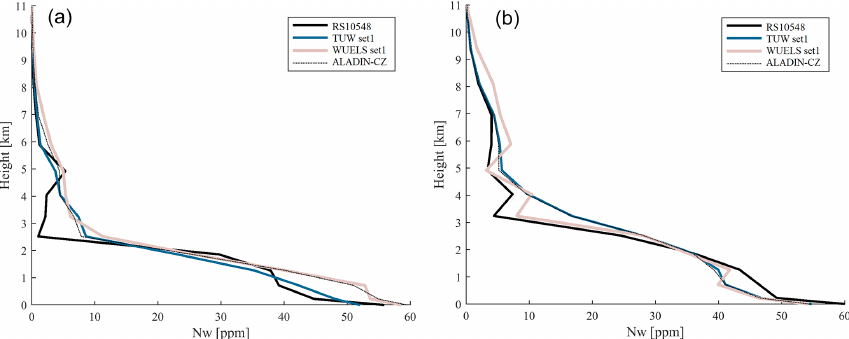
Figure 8. Wet refractivity profiles derived from radiosonde launches, ALADIN-CZ 6h forecast data, TUW and WUELS tomography set1 for 6 June 2013, 12:00UTC (a) and 13 June 2013, 00:00UTC (b) .